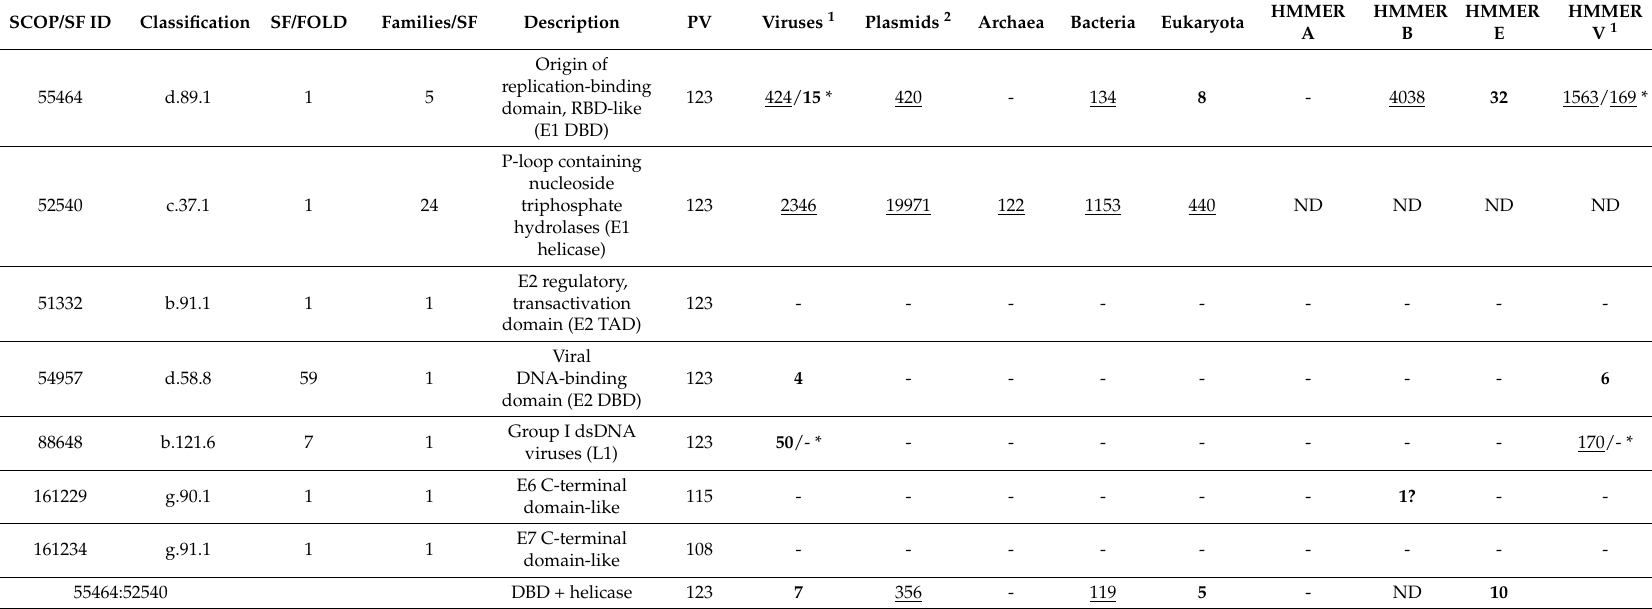
Table 3. PV_SF domain occurrence in